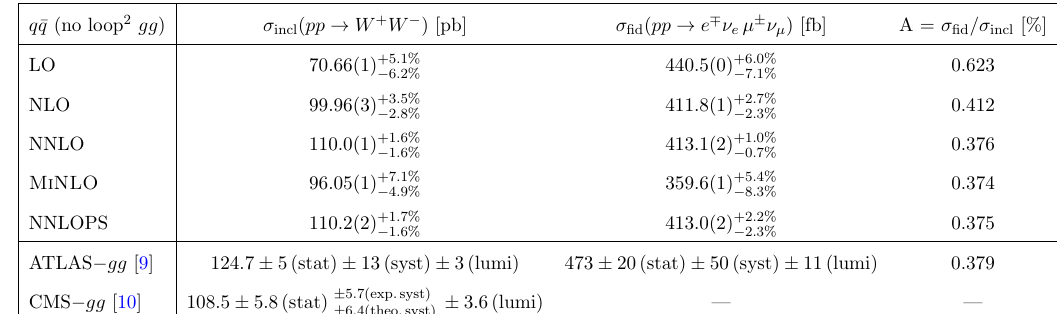
Table 2 . Cross sections for inclusive W + W (cid:0) production and e (cid:7) (cid:23) cuts in various approximations compared to data. At NNLO, all corrections to q (cid:22) q -bar induced W + W (cid:0) production are taken into account up to O ( (cid:11) 2 O ( (cid:11) 3 ) theoretical prediction for the (non-resonant) gg component [55] as quoted in the s